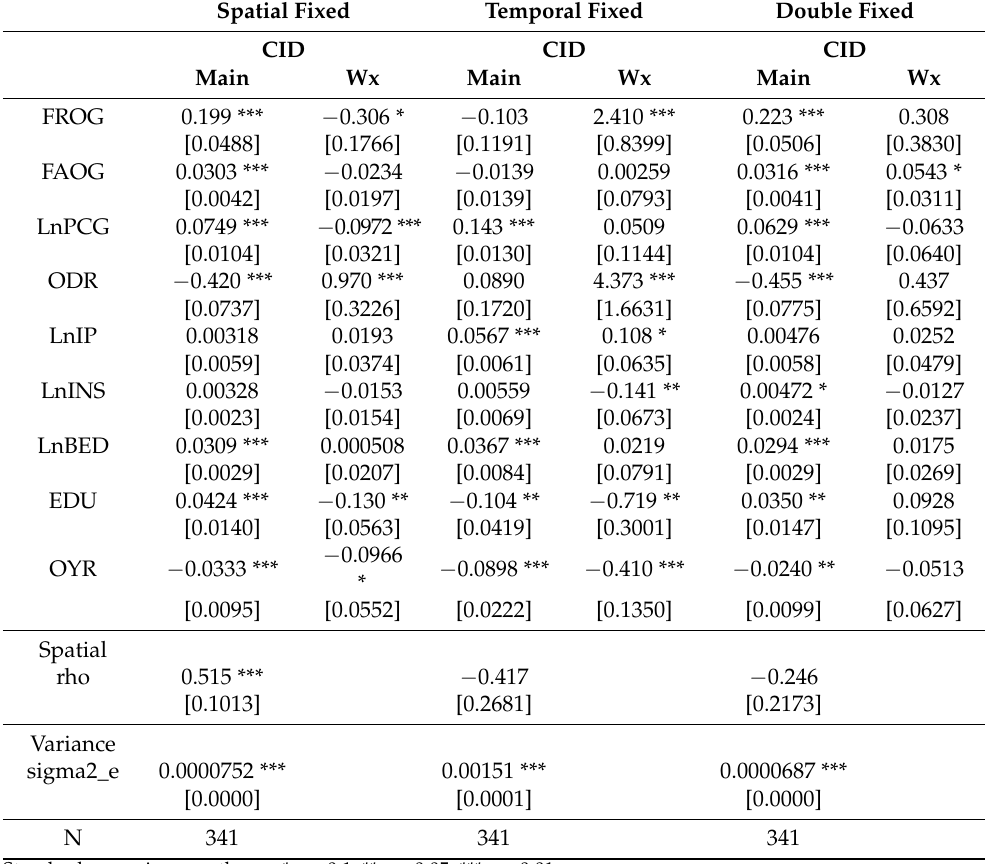
Table 9. SDM model estimation